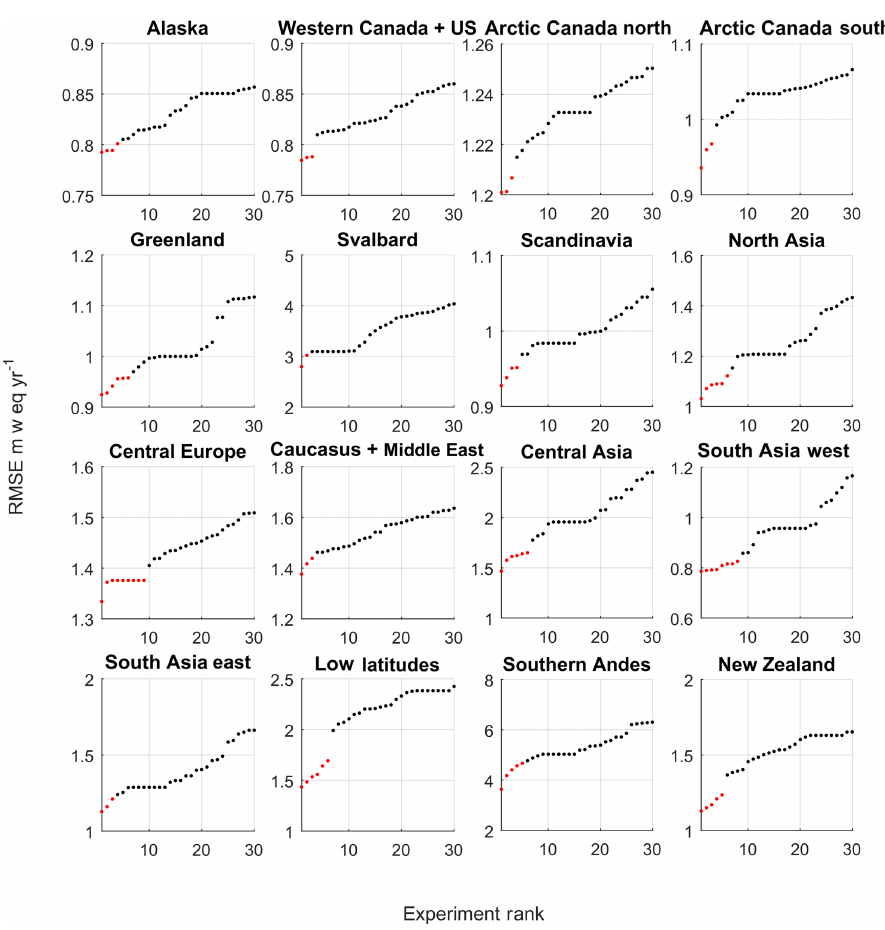
Figure 14. Calibration experiments ranked according the root-mean-square error between simulated and observed mass balance profiles for RGI6 regions. There are 198 experiments but only the top 30 have been plotted to make the figure easier to read. The red dots indicate experiments that perform equally